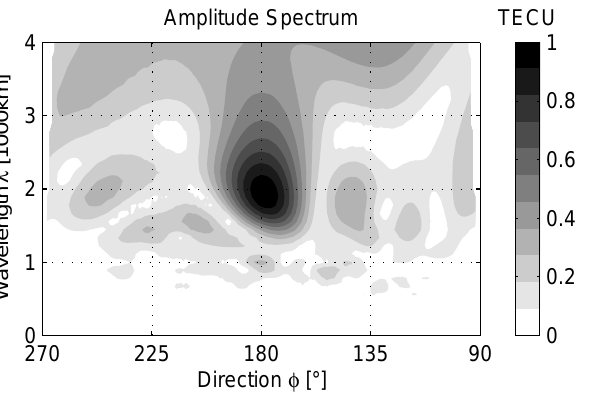
Fig. 5. Correlation of the auroral electrojet (AE) index with the maximum amplitude of the wave observed during the first 12h after the storm onset. Left: solar maximum (2001–2004); Right: solar minimum (2005-2007). Night time (21:00–03:00UT) storms are marked gray. The dashed lines represent the least squares fit, ex- cluding night time